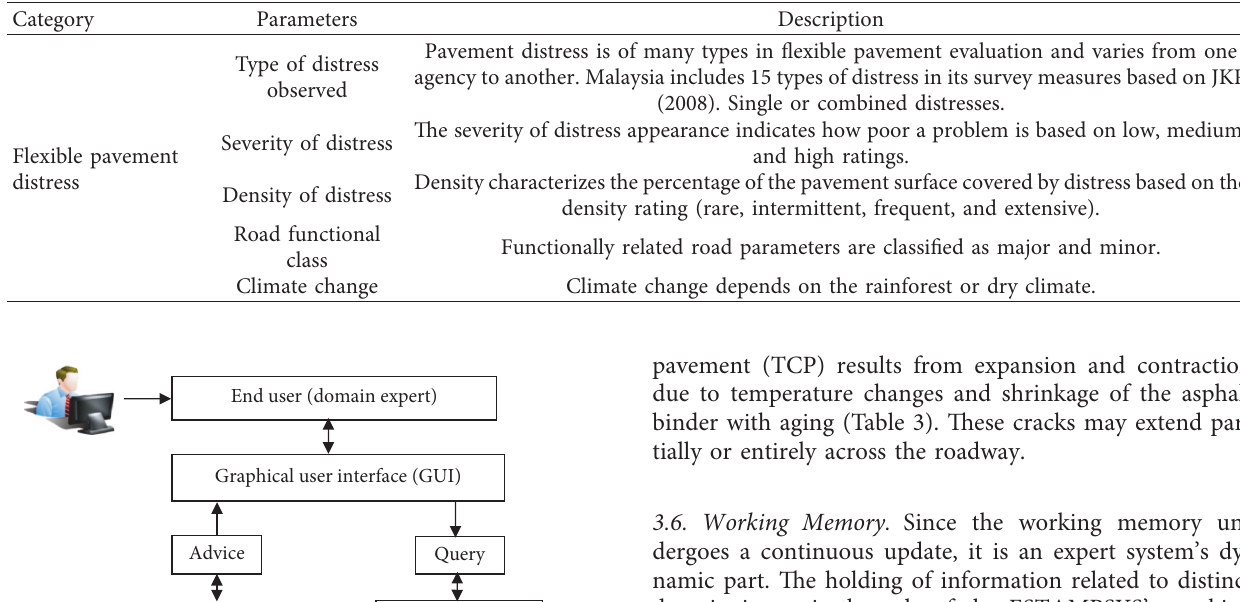
Table 2: The categorization of domain classification